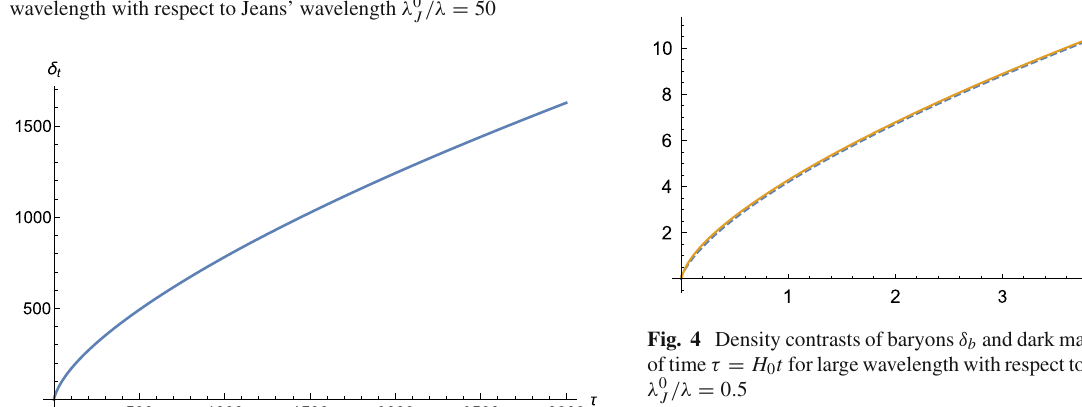
Fig. 1 Total density contrast δ t as a function of time τ = H 0 t for small wavelength with respect to Jeans’ wavelength λ 0